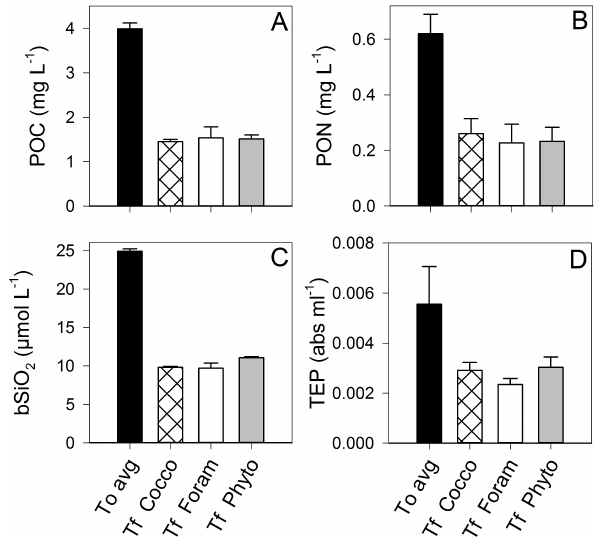
Fig. 5. Concentrations of suspended (A) POC, (B) PON, (C) bSiO 2 , and (D) TEP at the beginning of the experiment (T o , representing an average of all three treatments) and at the end of the experiment (T f , representing an average of the replicate tanks for each